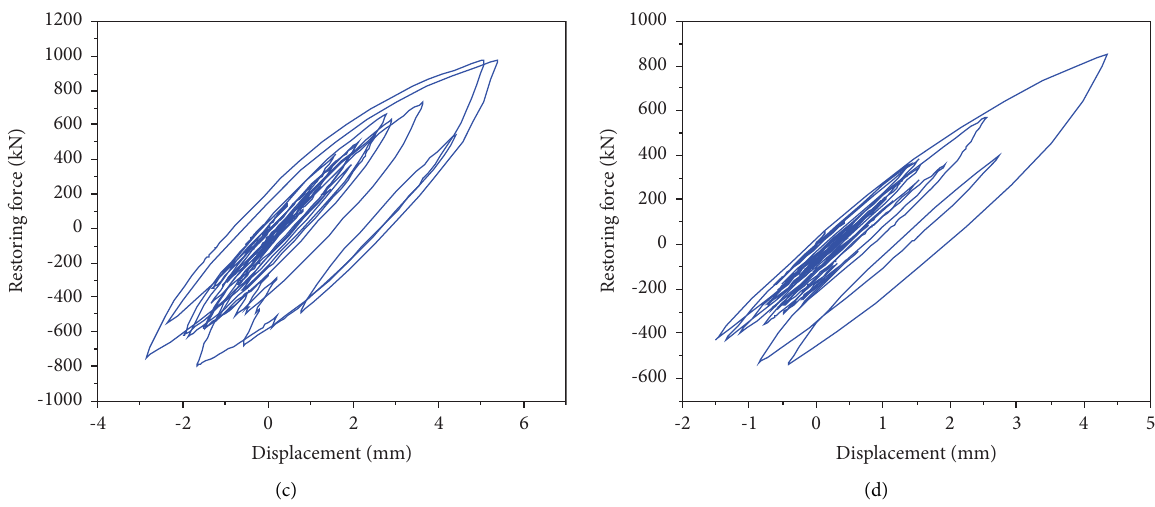
Figure 14: Hysteresis cycles of dampers under TABAS seismic waves. (a) First foor. (b) Second foor. (c) Tird foor. (d) Fourth